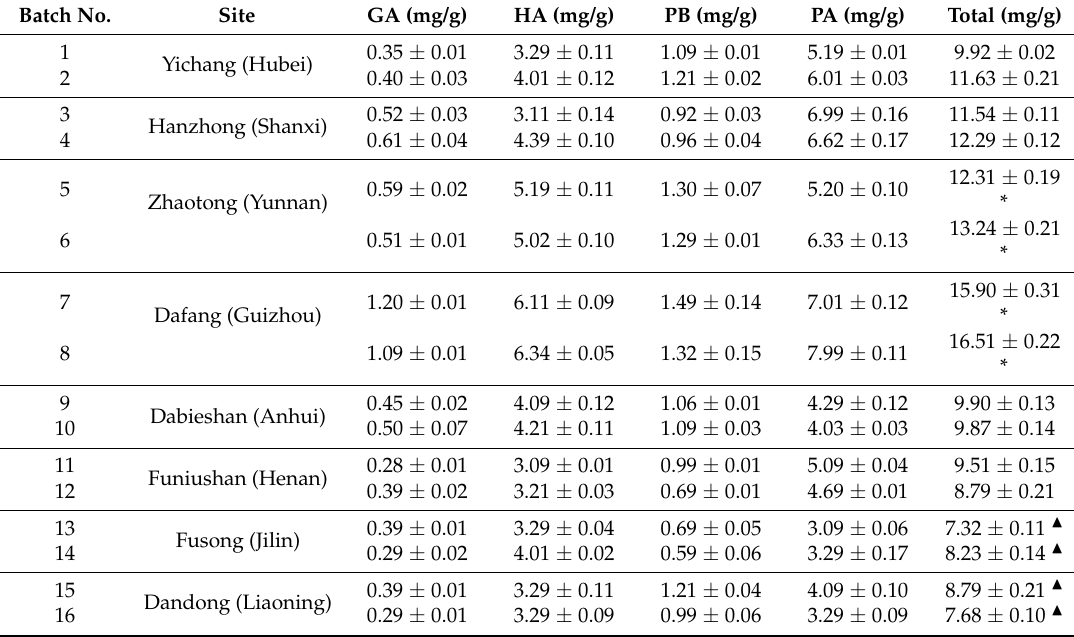
Table 3. Contents of four phenolic compounds in 16 batches of G. elata samples ( n = 10). Batch No.